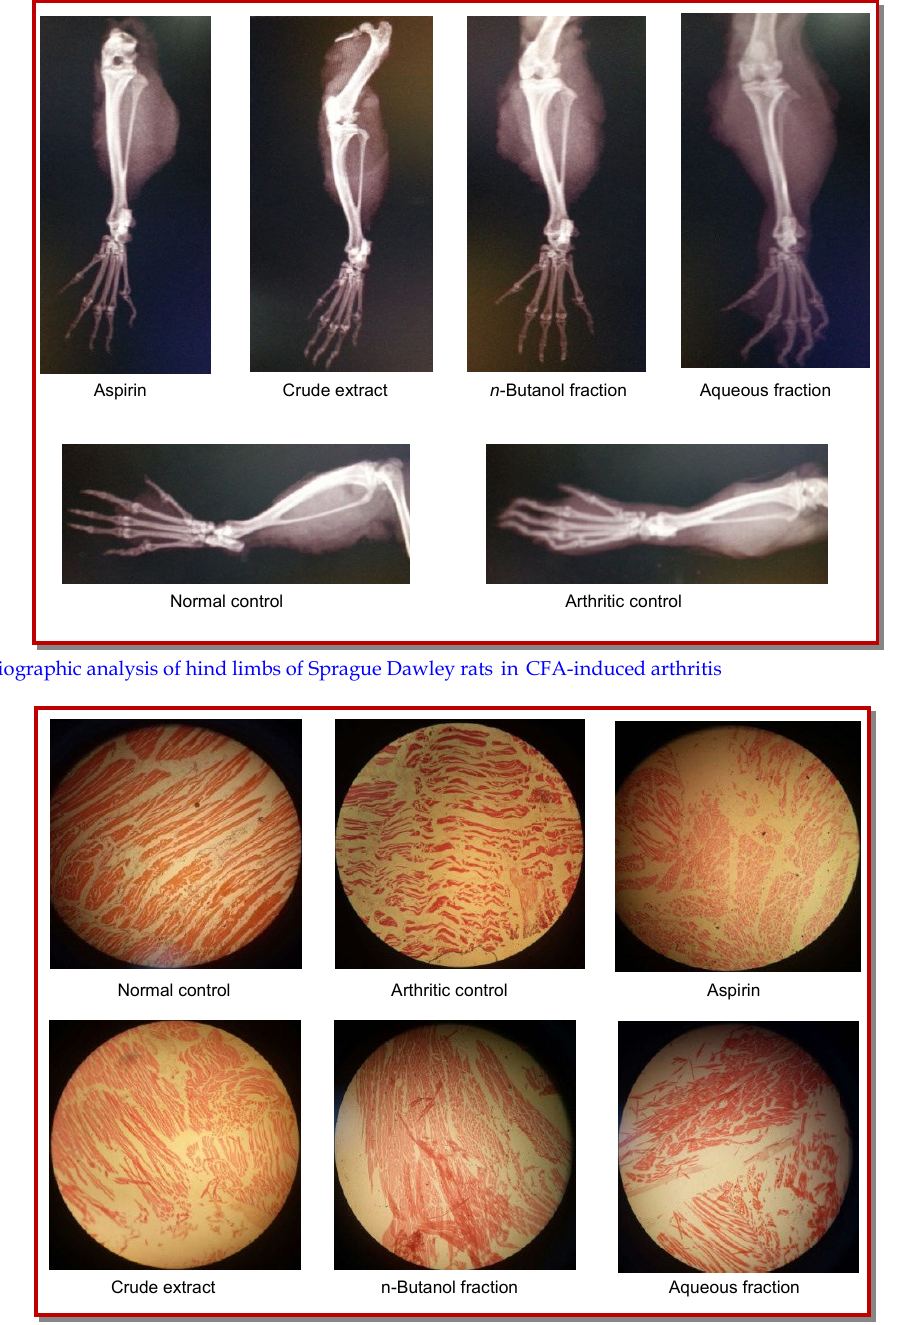
Figure 3: Effects of different treatments on histopathological changes in ankle joints of Sprague Dawley